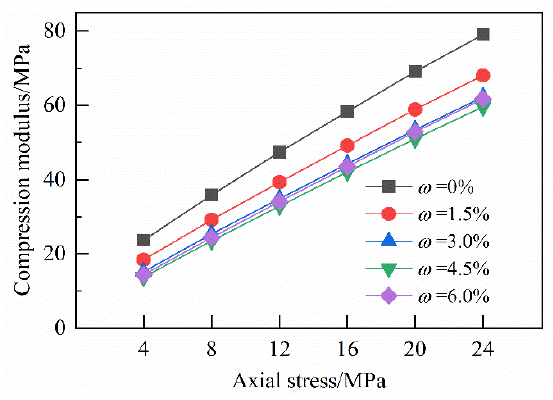
Figure 8. Relationship curves between compression modulus and axial stress.